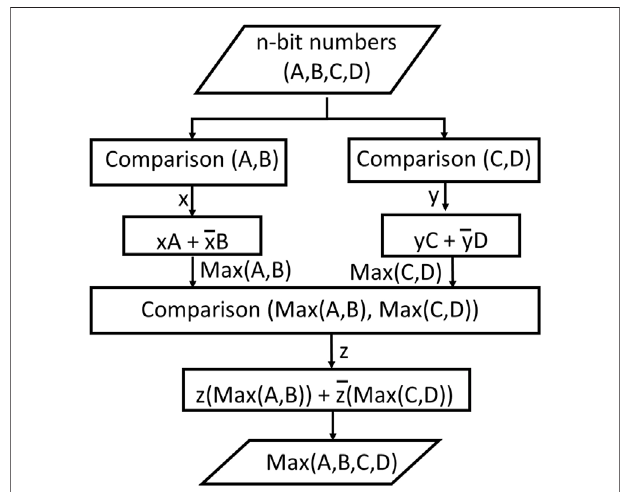
FIGURE 7 | Maxpooling operation on pooling window of 2 × 2.